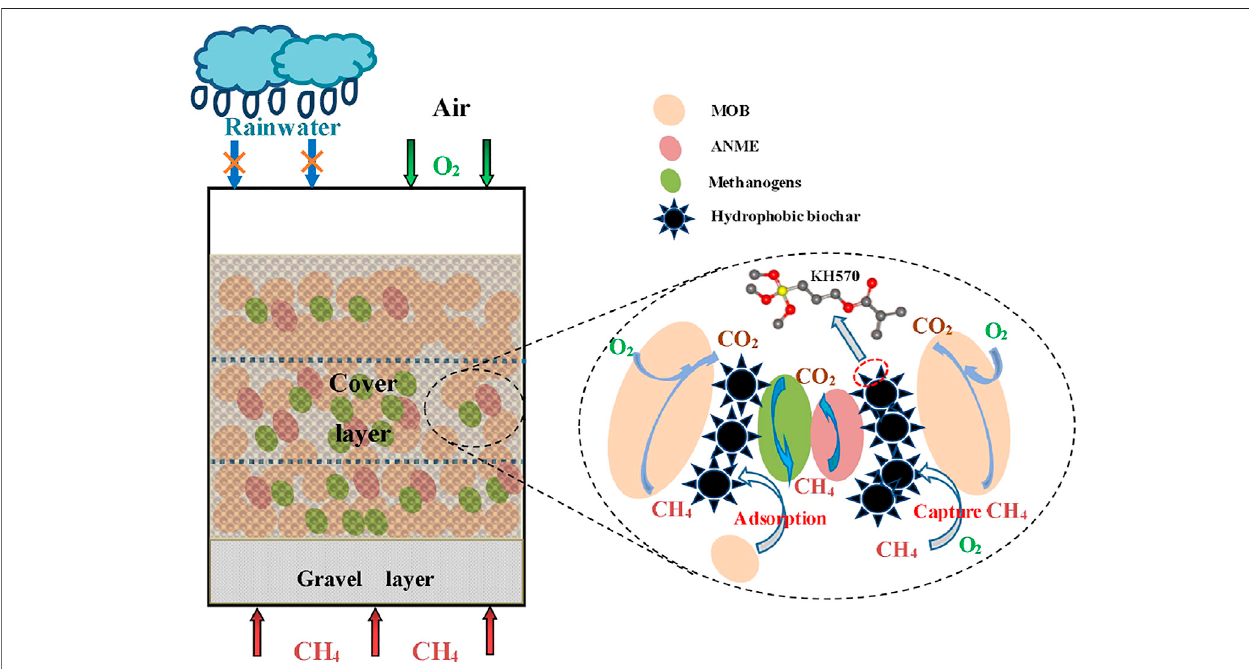
FIGURE 7 | Biological mechanism diagram of